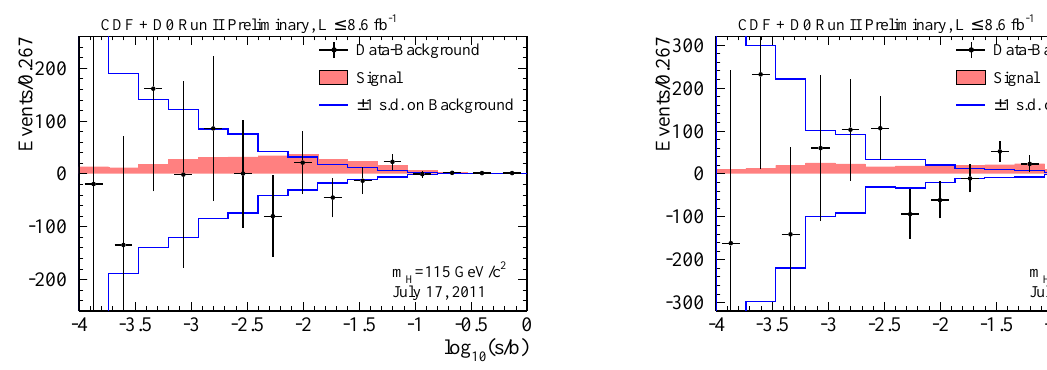
Fig. 1. Background-subtracted distributions of lo g 10 ( s / b ) for the data from all contributing channels from the combined CDF and D0 analyses for m H = 115 GeV / c 2 .